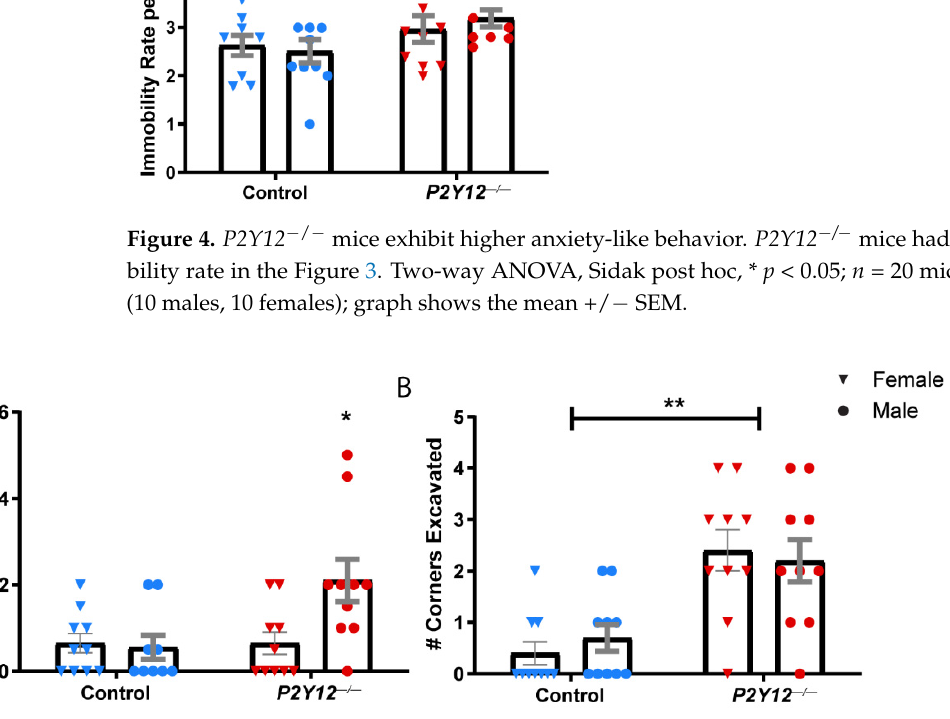
Figure 5. P2Y12 − / − mice exhibit increased repetitive behaviors: ( A ) male P2Y12 − / − mice exhibited increased burying behavior; ( B ) both male and female P2Y12 − / − mice exhibited increased digging behavior. ( A , B ): two-way ANOVA, Sidak post hoc, * p < 0.05, ** p < 0.0001; n = 20 mice per genotype (10 males, 10 females); graph shows the mean +/ − SEM.